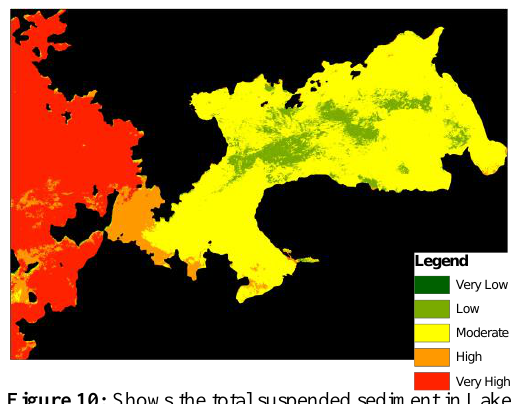
Figure 10: Shows the total suspended sediment in Lake Victoria The hyacinth spread denotes a small correlation between the values, influenced by outliers as is evidenced in 2020 and 2018 water hyacinth coverage in Figure 11